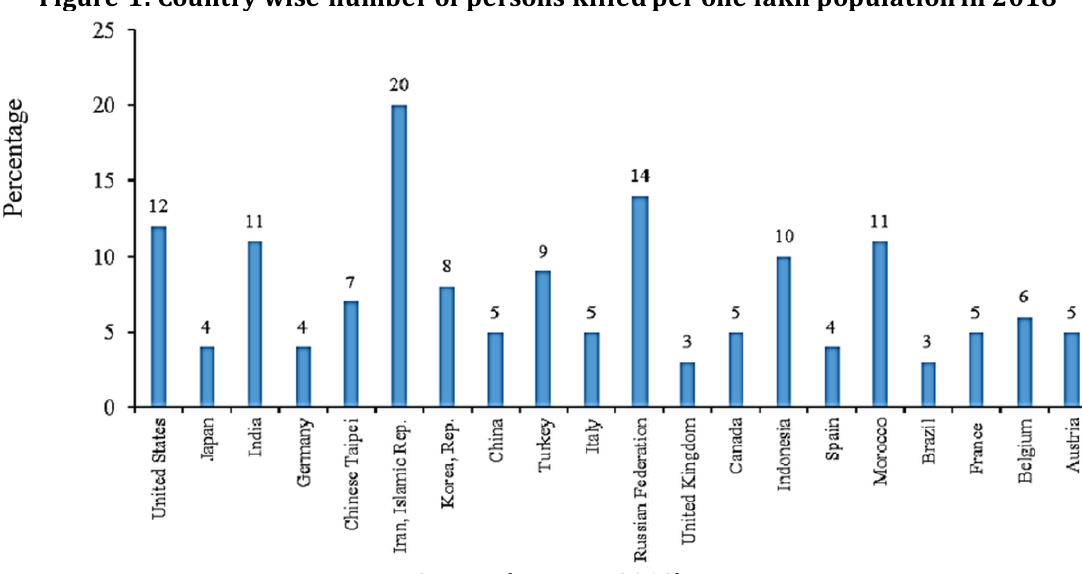
Figure 1: Country wise number of persons killed per one lakh population in 2018